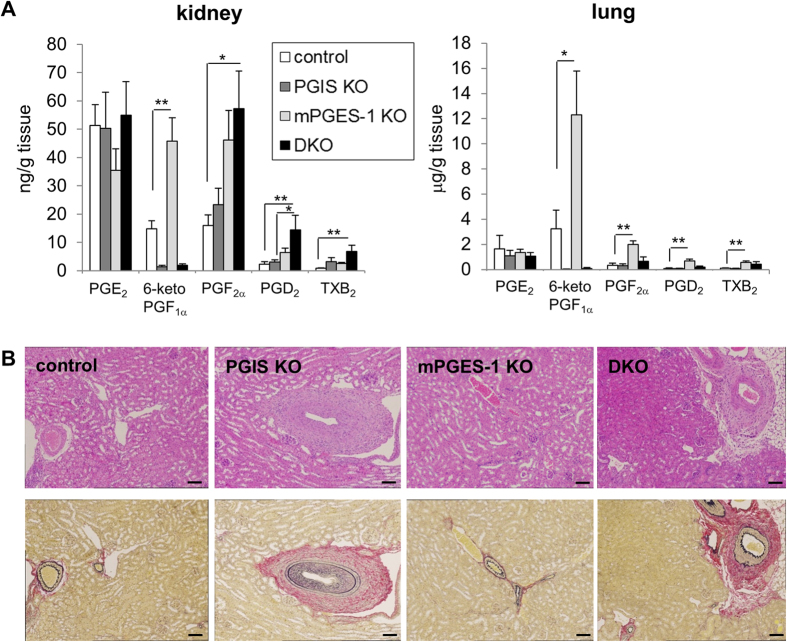
Prostanoid levels in kidney and lungs and histological features of kidney prepared from PGIS and/or mPGES-1 KO mice.(A) Prostanoid levels in kidneys and lungs. Kidneys and lungs were resected from mice and then homogenized. Their lipids were extracted and subjected to a lipidomics analysis by LC-ESI-MS. Results are mean ± SEM (n = 3–6). *P < 0.05 and **P < 0.01 vs. control. (B) Histological features of kidneys. Sections of kidneys were stained with hematoxylin and eosin (H&E, upper panel) or Elastica van Gieson stain (lower panel). Bar: 100 μm.